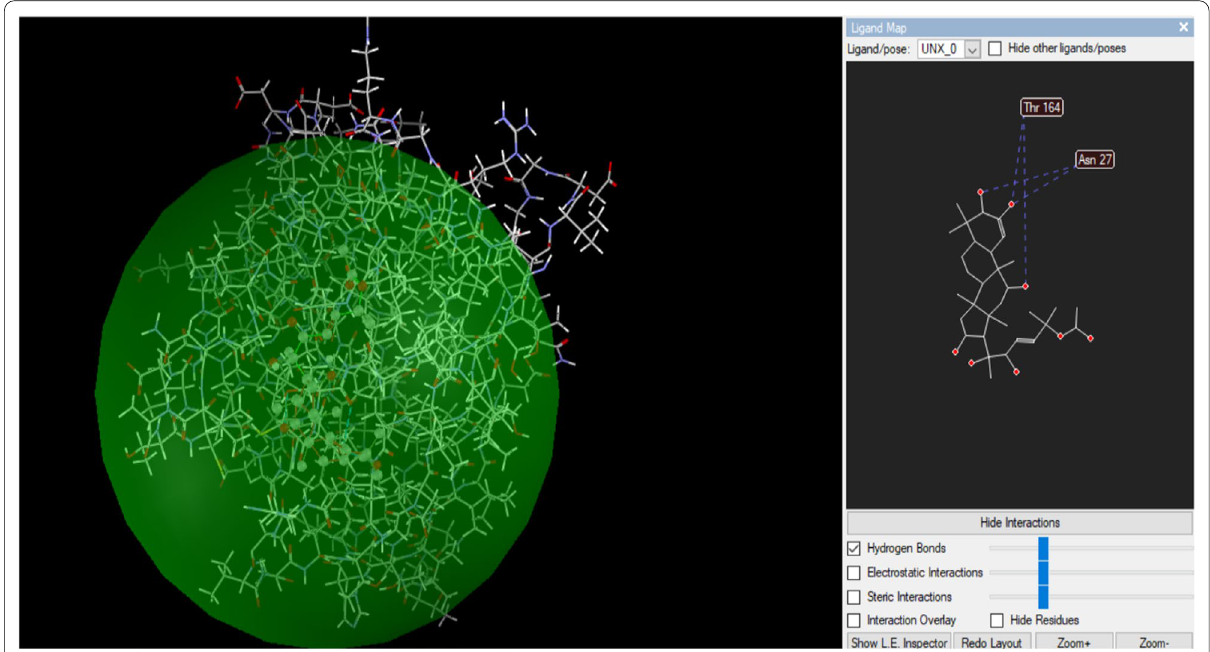
Fig. 18 The 3D representation of Cucurbitacin E at the active site of G. mellonella SOD enzyme (Hydrogen bonds; Thr 164, Thr 164; Asn 27, Asn